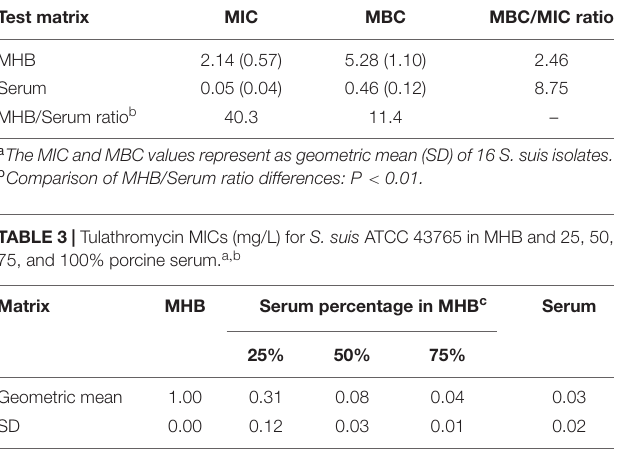
TABLE 1 | Pharmacokinetic parameters of tulathromycin in porcine serum after single intravenous (IV) and intramuscular (IM) administrations at 2.5 mg/kg. a Parameter b